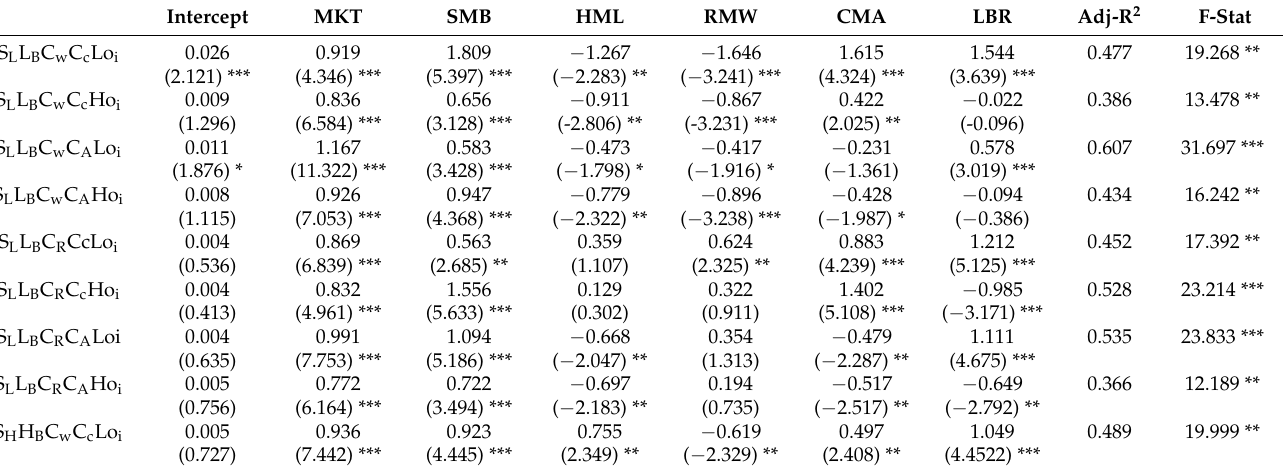
Table 9. Human-Capital Six-Factor